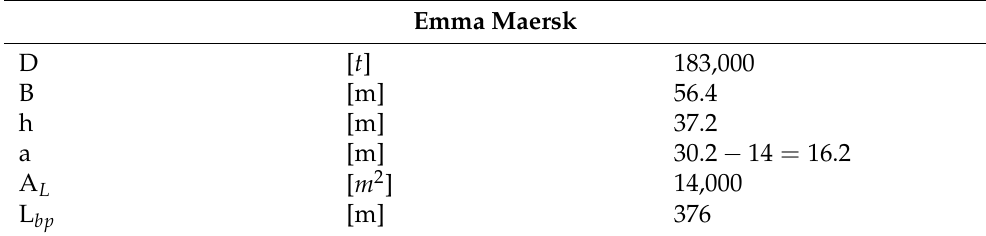
Table 1. Emma Maersk